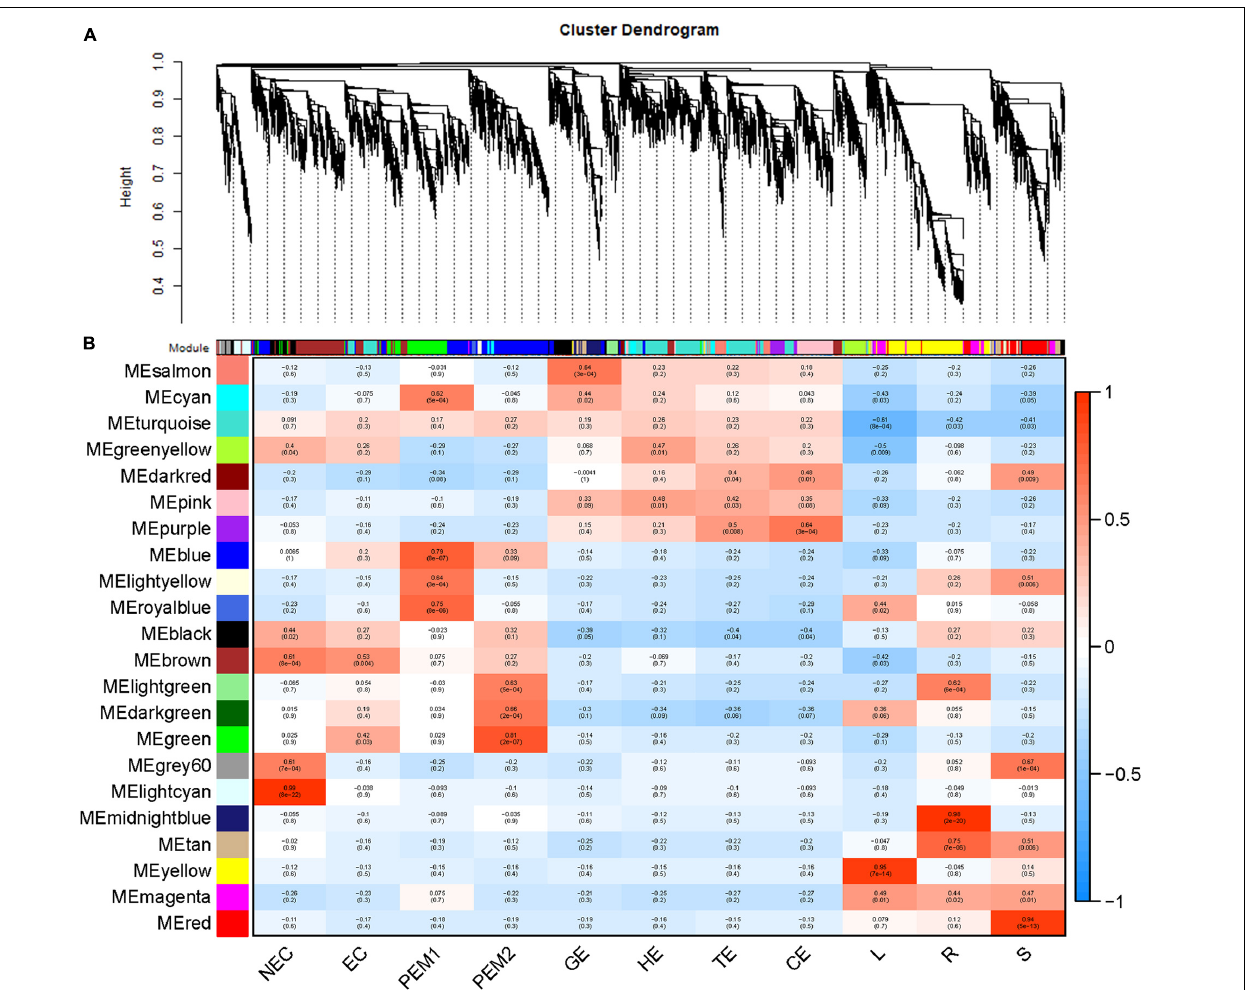
FIGURE 6 | WGCNA of genes in eleven tissues. (A) Hierarchical cluster tree showing coexpression modules identified by WGCNA. Each leaf in the tree is one gene. The major tree branches constitute 22 modules labeled by different colors. (B) Module-tissue association. Each row corresponds to a module. The number of genes in each module is indicated on the left. Each column corresponds to a specific tissue. The color of each cell at the row-column intersection indicates the correlation coefficient between the module and the tissue type. A high degree of correlation between a specific module and the tissue type is indicated by